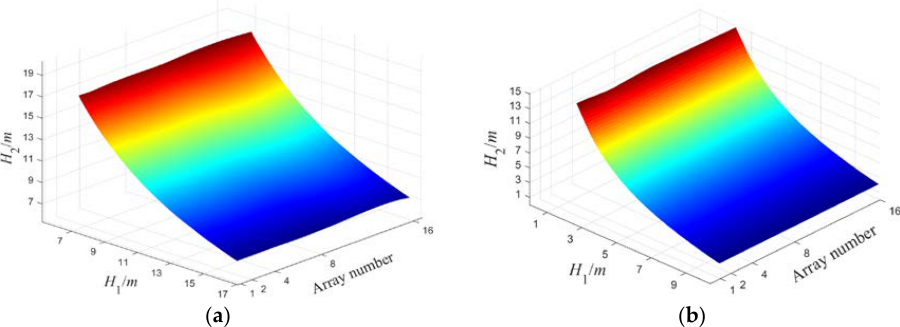
Figure 14. Trend map of height optimization result: ( a ) hexagonal hourglass lattice ( b ) triangular hourglass lattice.